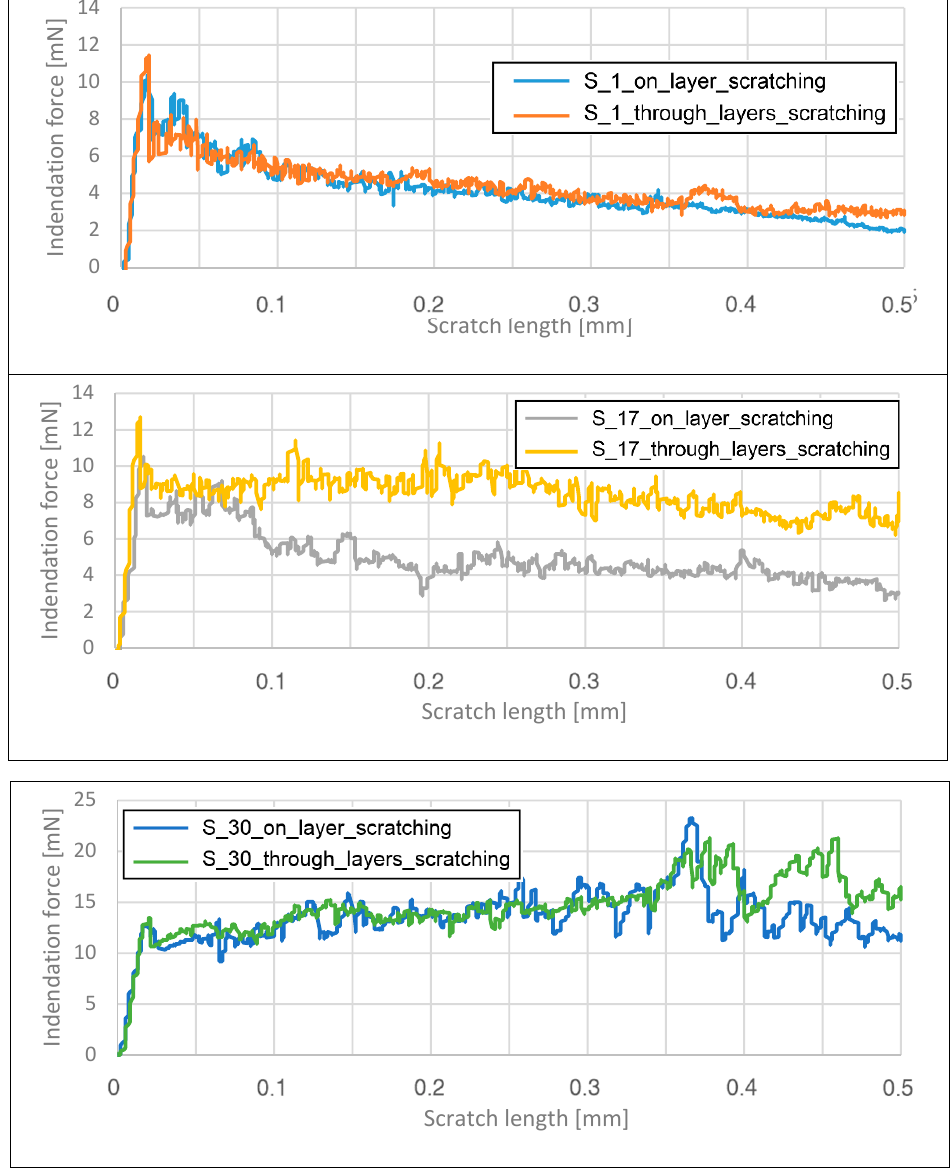
Figure 11. Variation in the indentation force as a function of the scratch length.